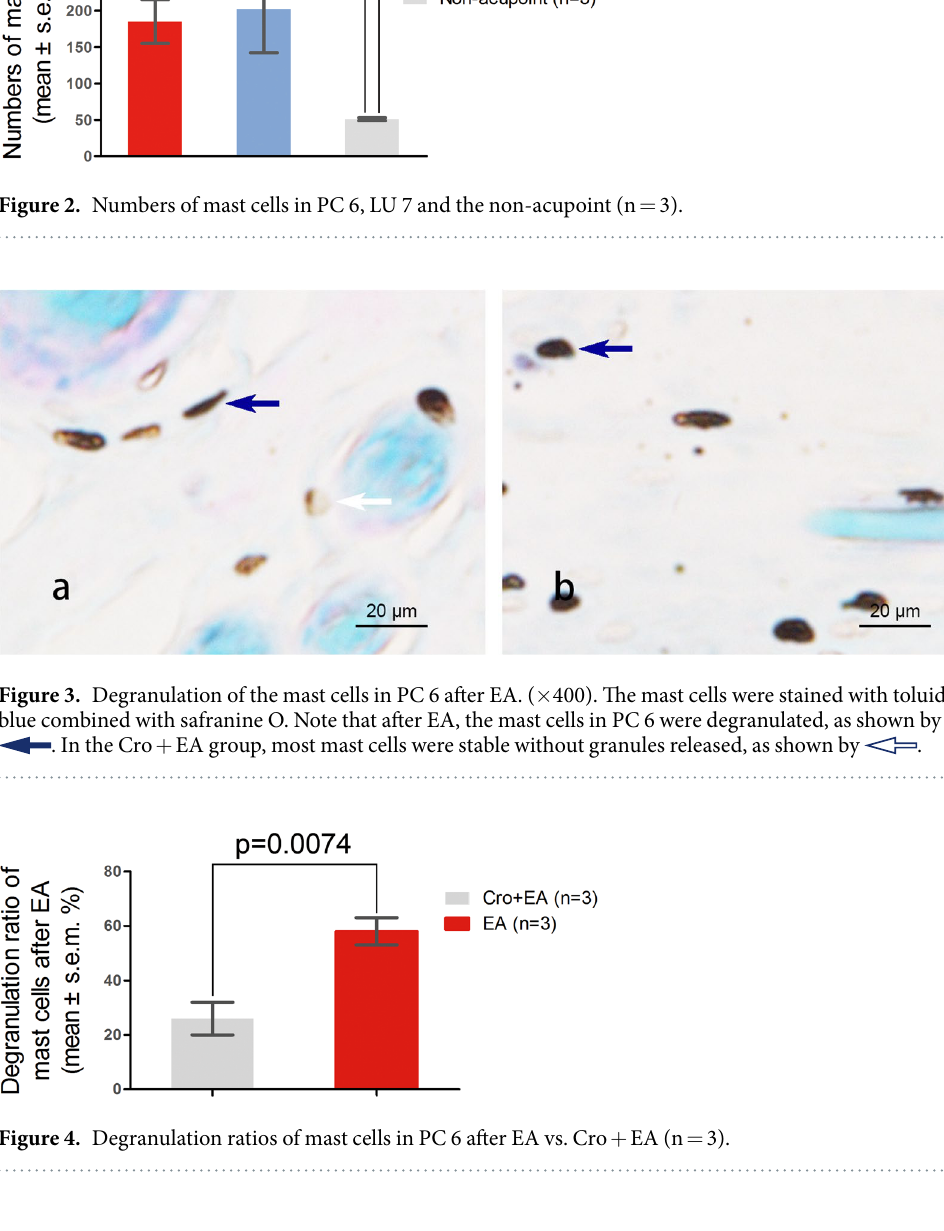
3 Scientific RepoRts | 7: 9040 | DOI:10.1038/s41598-017-08855-5